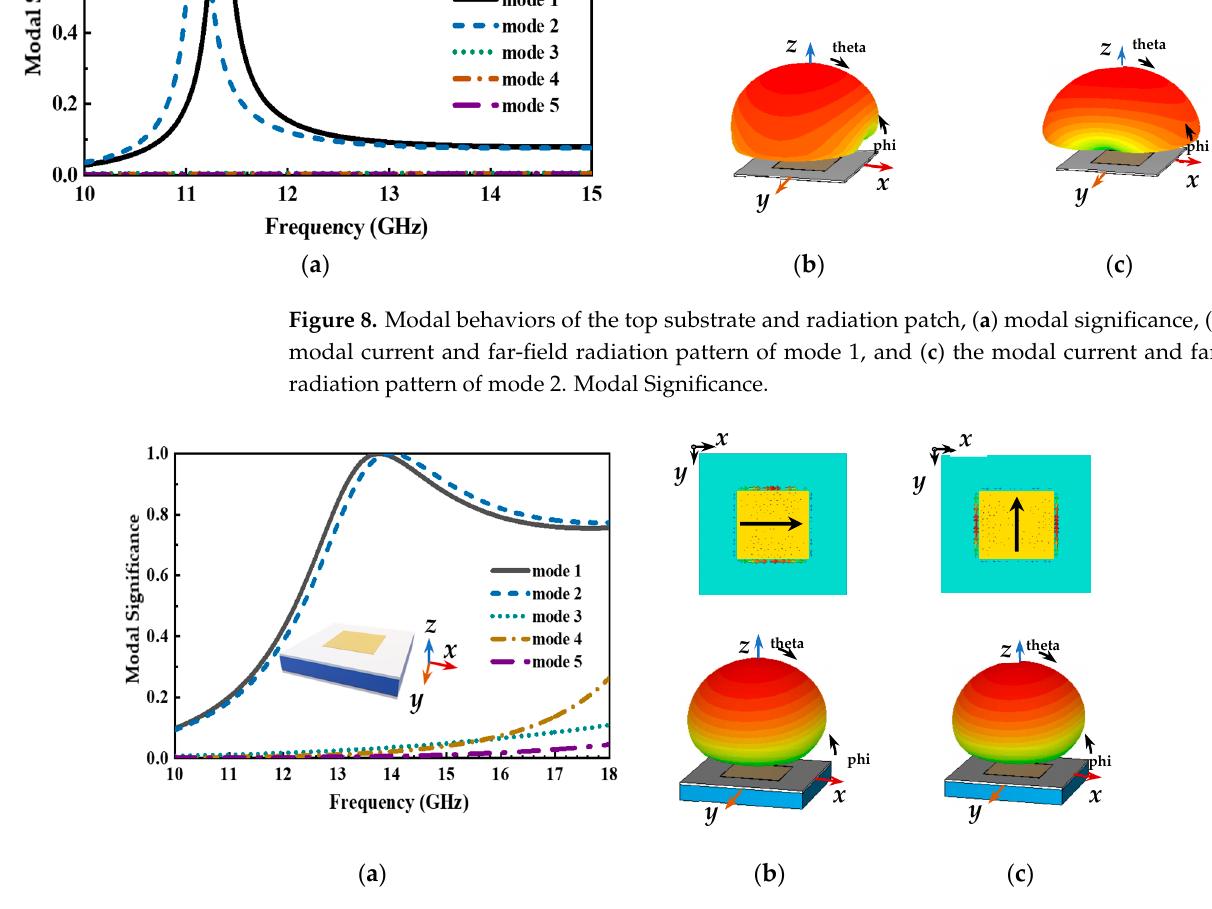
( b ) Figure 10. Various bending modal behaviors of the top substrate, radiation patch, and honeycomb equivalent layer, ( a ) bending states, and ( b ) modal significance. 4. Analysis of Simulation and Measurement Results As an important frequency band for space satellite communications, Ku-band was used as the operating frequency band for the proposed CLA. Its central frequency point was 12.5 GHz. To demonstrate the feasibility of the design above, the proposed conformal antenna element and antenna array were simulated based on the optimized dimensions by CST, and its optimized dimensions are tabulated in Table 1. The equivalent medium model of the honeycomb core layer was applied to the simulation of the proposed anten- nas. Then, the prototypes were processed and measured by a vector network analyzer (PNA-X5244A) and microwave anechoic chamber in our laboratory. The proposed an- tenna element and antenna array were mounted on the mold through nylon screws, re- spectively, for conformability testing.